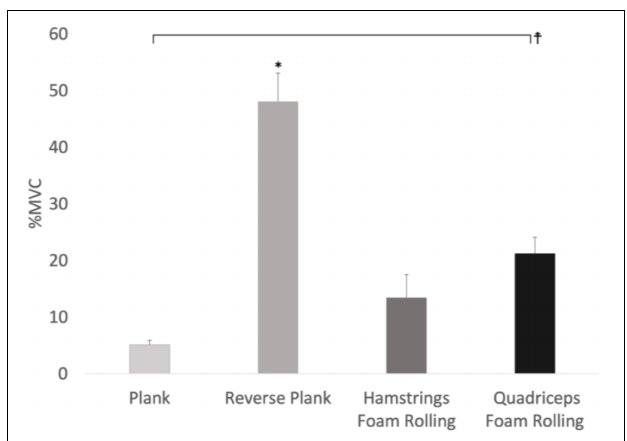
FIGURE 6 | Main effect for conditions with lumbo-sacral erector spinae muscle EMG activity. ∗ Significance difference between reverse plank with plank, hamstrings foam rolling, and quadriceps foam rolling ( p < 0.05). ? Significant difference between the conditions ( p < 0.05), %MVIC refers to